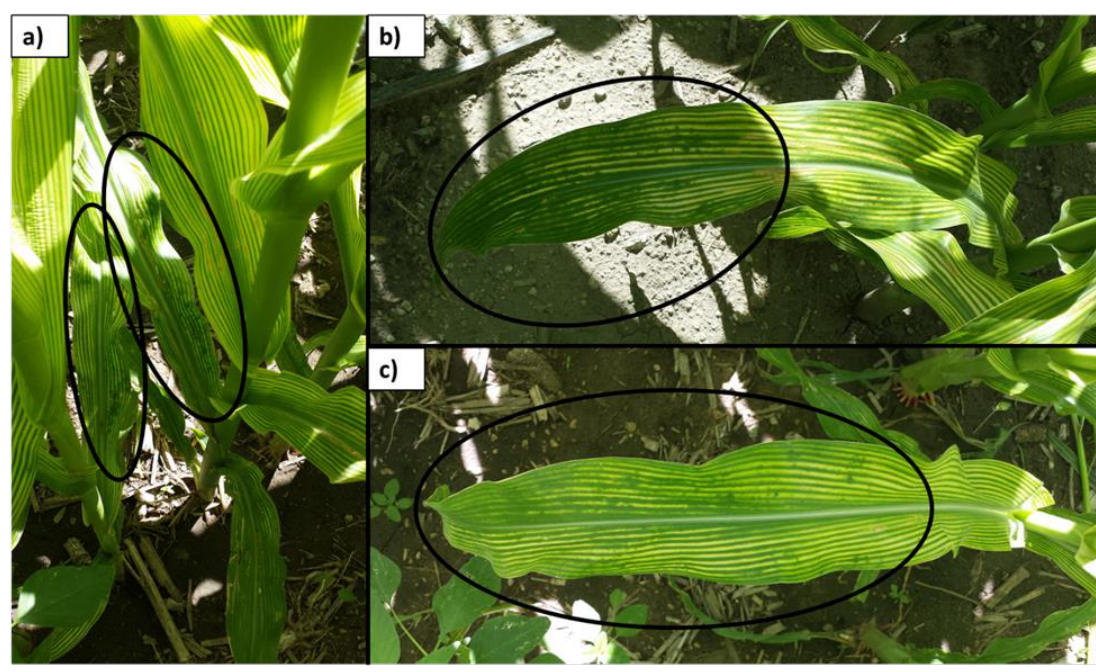
Figure 2. Images from foliar Fe treated maize plants showing regreening patterns where foliar Fe droplets contacted the leaf surface on the V5 leaf ( b , c ). No regreening appears in upper untreated leaves ( a ).